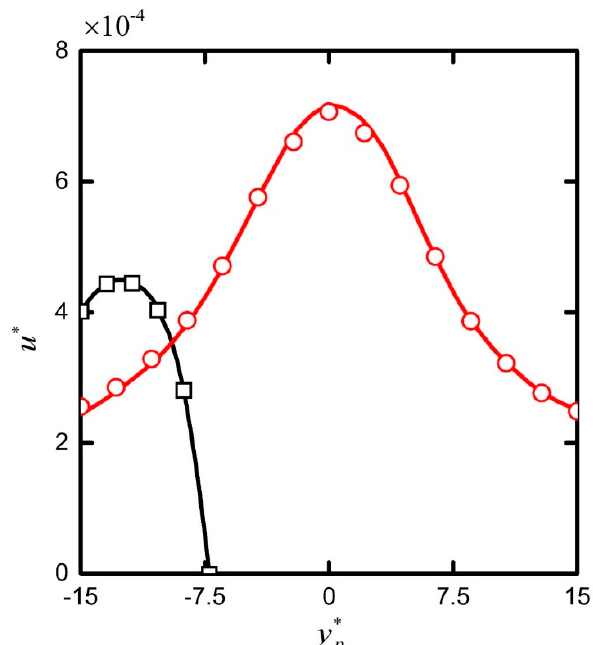
Figure 2. The y-component translational velocity u* of the cylinder particle as a function of the particle’s location y* p under E = 20 KV / m, the ratio of the particle radius to the Debye length, ka = 1.03 (red line and circles), 0.46 (black lines and squares). Symbols and lines represent, respectively, the numerical solution of reference [26] and the numerical results from the present model.